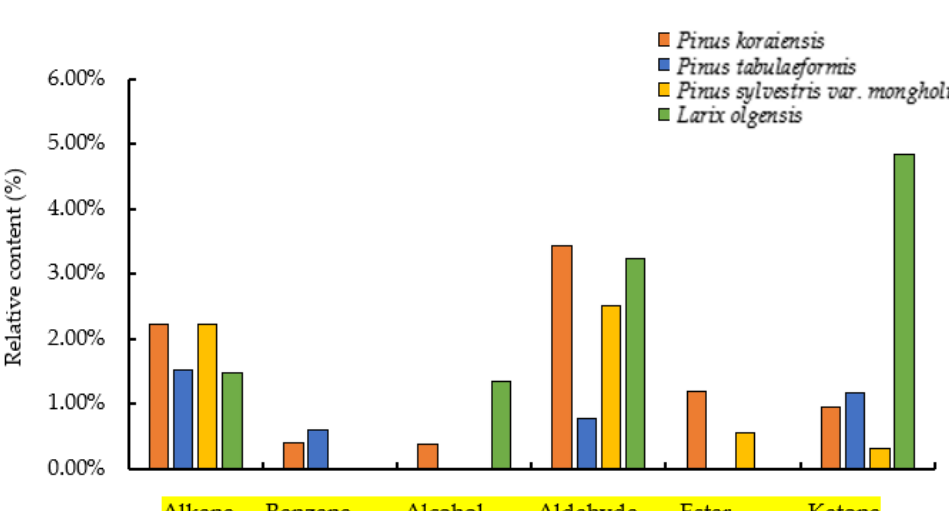
Figure 2. Volatile composition of different host pine